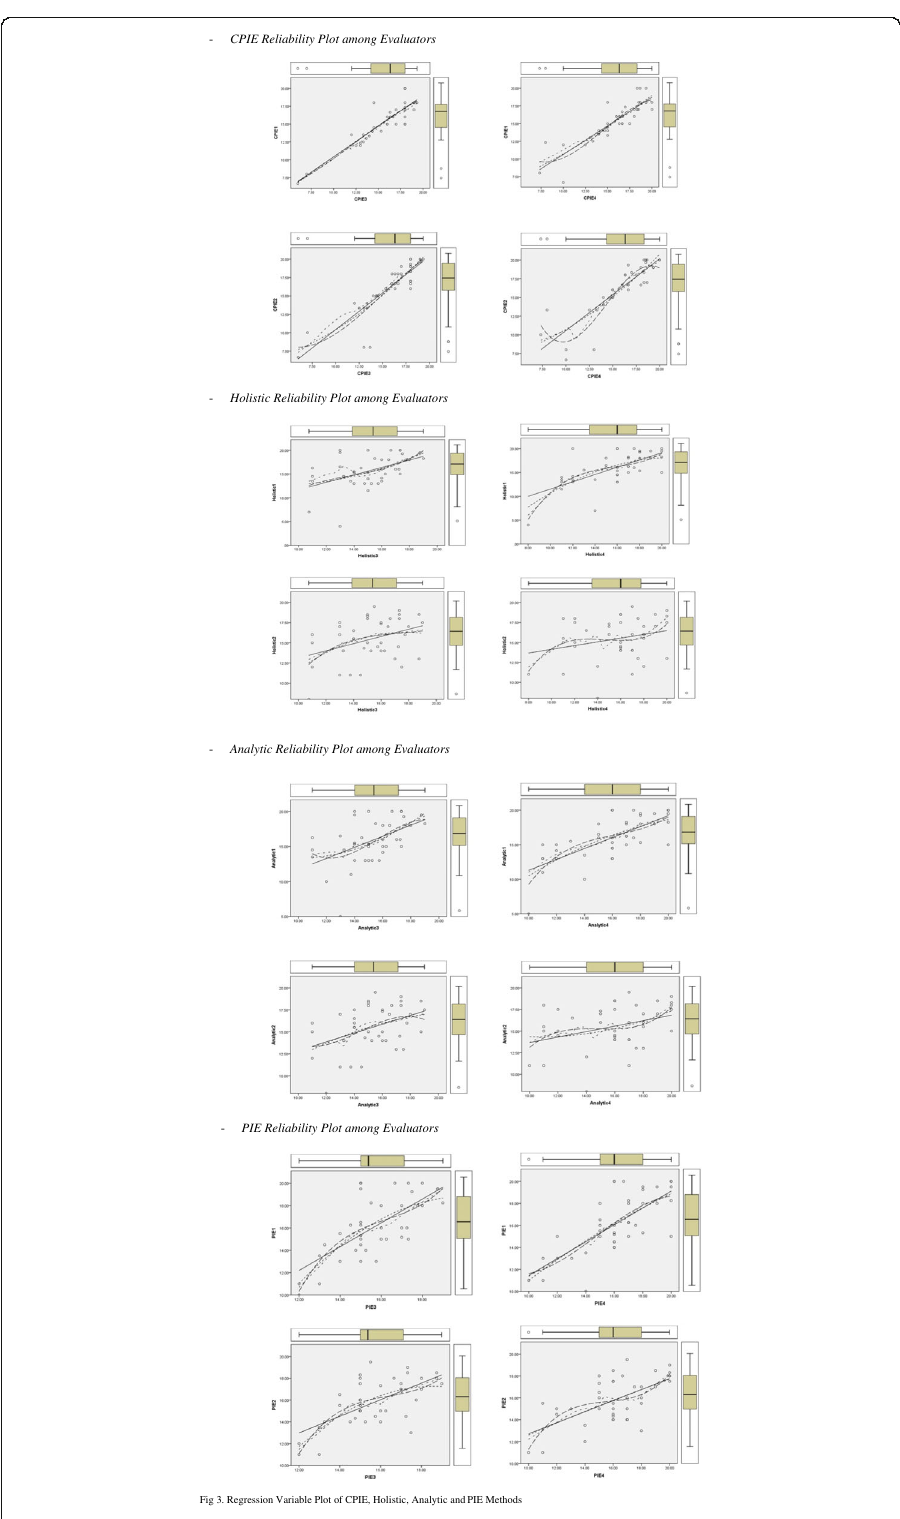
Fig 3. Regression Variable Plot of CPIE, Holistic, Analytic and PIE Methods Fig. 3 Regression variable plot of CPIE, holistic, analytic, and PIE methods. A regression variable plot was applied to predict the value of the variable on the basis of the relationship among the evaluators. There were few outliers among the CPIE evaluators, which clearly showed that CPIE evaluators were more consistent with one another when scoring the translation